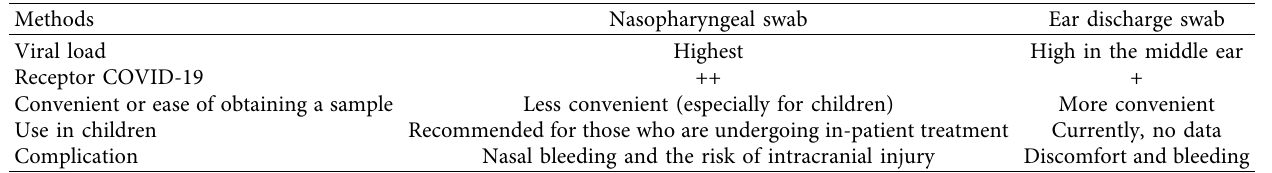
Table 2: Comparison of nasopharyngeal swab and ear discharge swab for COVID-19